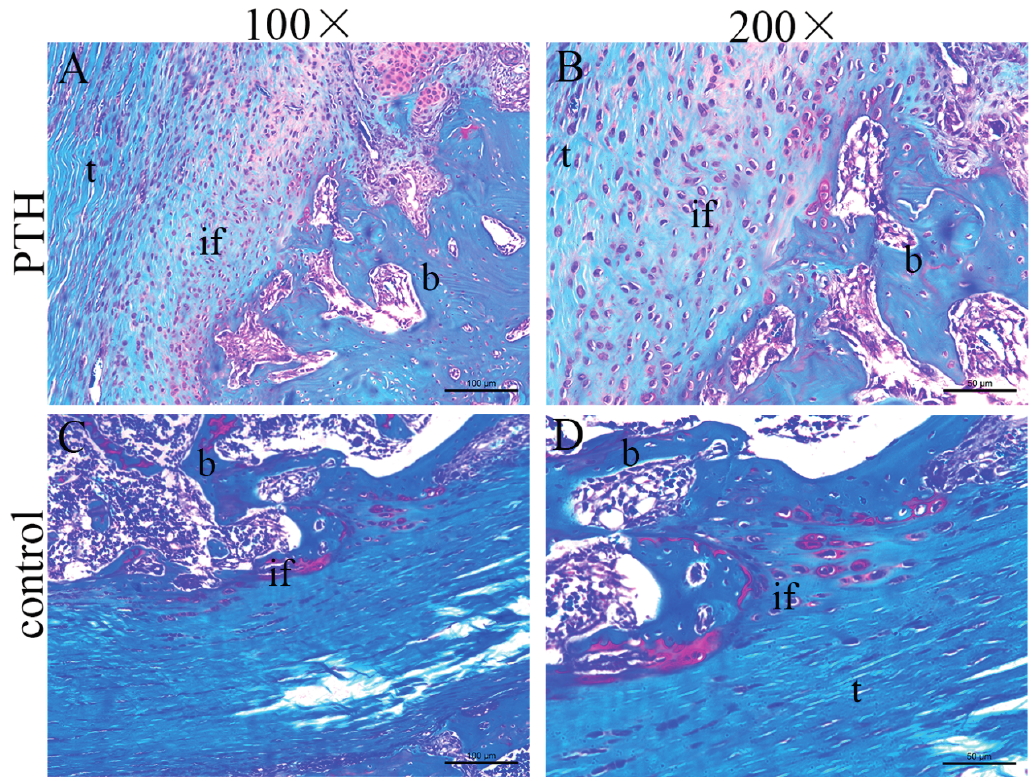
Figure 2. Histological observation of the tendon-bone interface in the PTH group ( A , B ) and the control group ( C , D ) by Safranin O staining (t, tendon; b, bone; if,